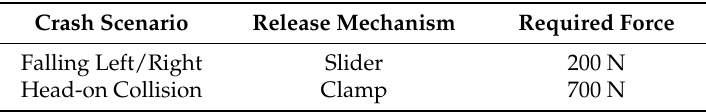
Table 1. Release mechanism summary.